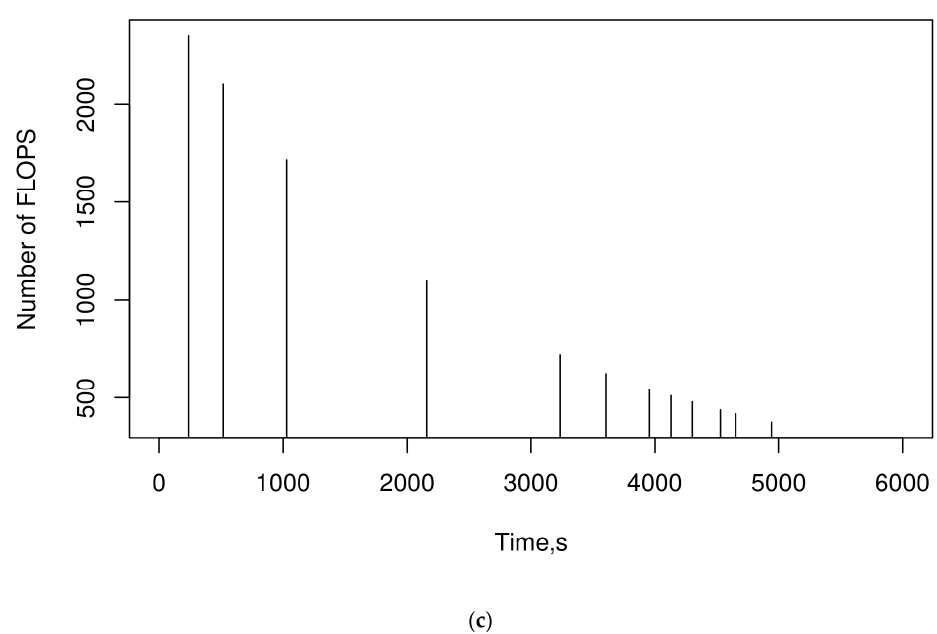
Figure 6. FLOPS of ( a ) BoT-IoT, ( b ) IoTID20, and ( c ) TON-IoT.